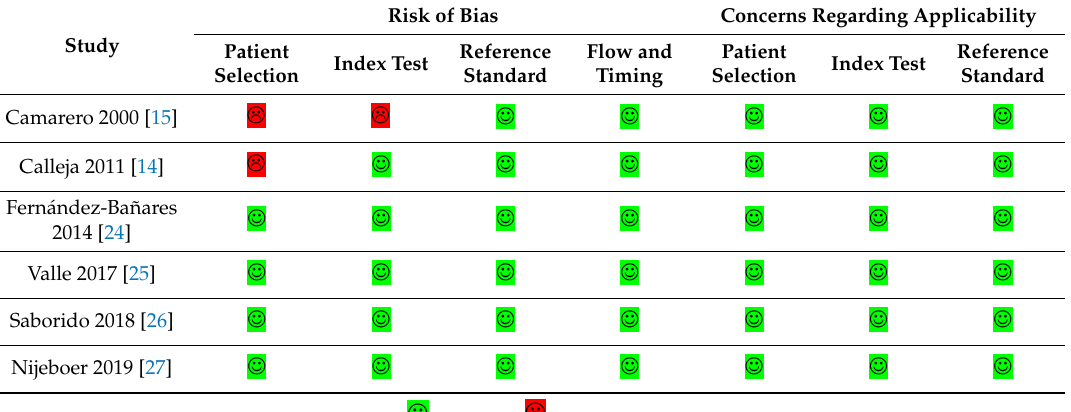
Table 3. Results of Quality Assessment of Studies of Diagnostic Accuracy included in Systematic Reviews (QUADAS-2) checklist.